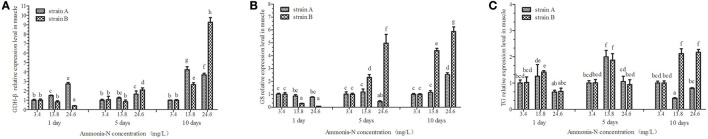
The effect of ammonia-N on the expression of GDH-β,GS, and TG genes expression in muscles from strains A and B. Different letters indicated significant differences at the level of 0.05. (A)
GDH-β gene relative expression level in the muscle of strain A and B. (B)
GS gene relative expression level in the muscle of strain A and B. (C)
TG gene relative expression level in the muscle of strain A and B. Keys: GDH, Glutamate dehydrogenase; TG, Transglutaminase; GS, Glutamine synthetase.